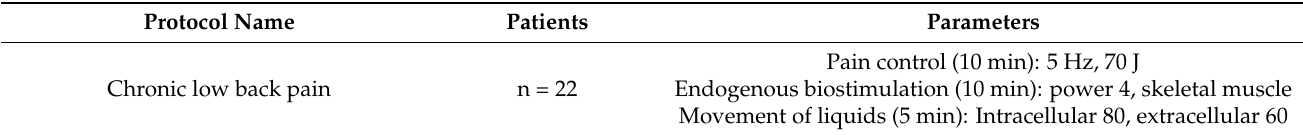
Table 1. Magnetic field protocol.